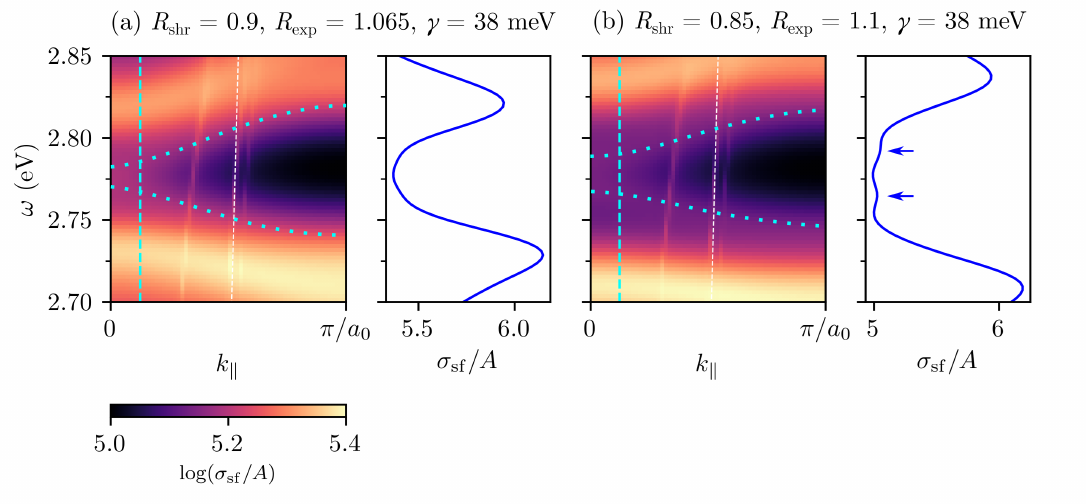
Figure A2. Spectral functions σ sf for ribbons with material losses γ = 38 meV, with geometrical parameters ( a ) R shr = 0.9 and R exp = 1.065 and ( b ) R shr = 0.85 and R exp =